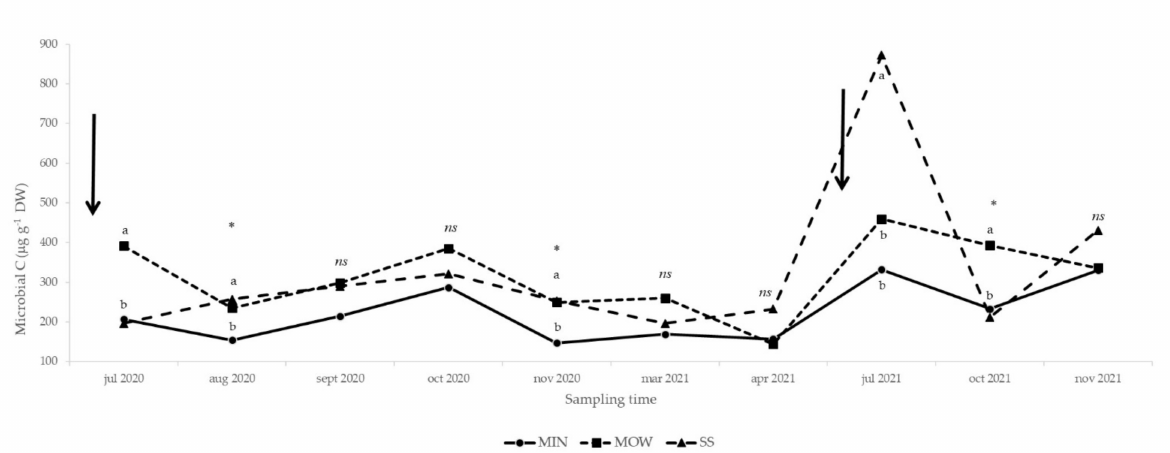
Figure 3. Effect of fertilization treatments on soil microbial biomass C concentration from July 2020 to November 2021. Arrows: amendment applications (20 April 2020 and 17 June 2021). MIN: mineral;